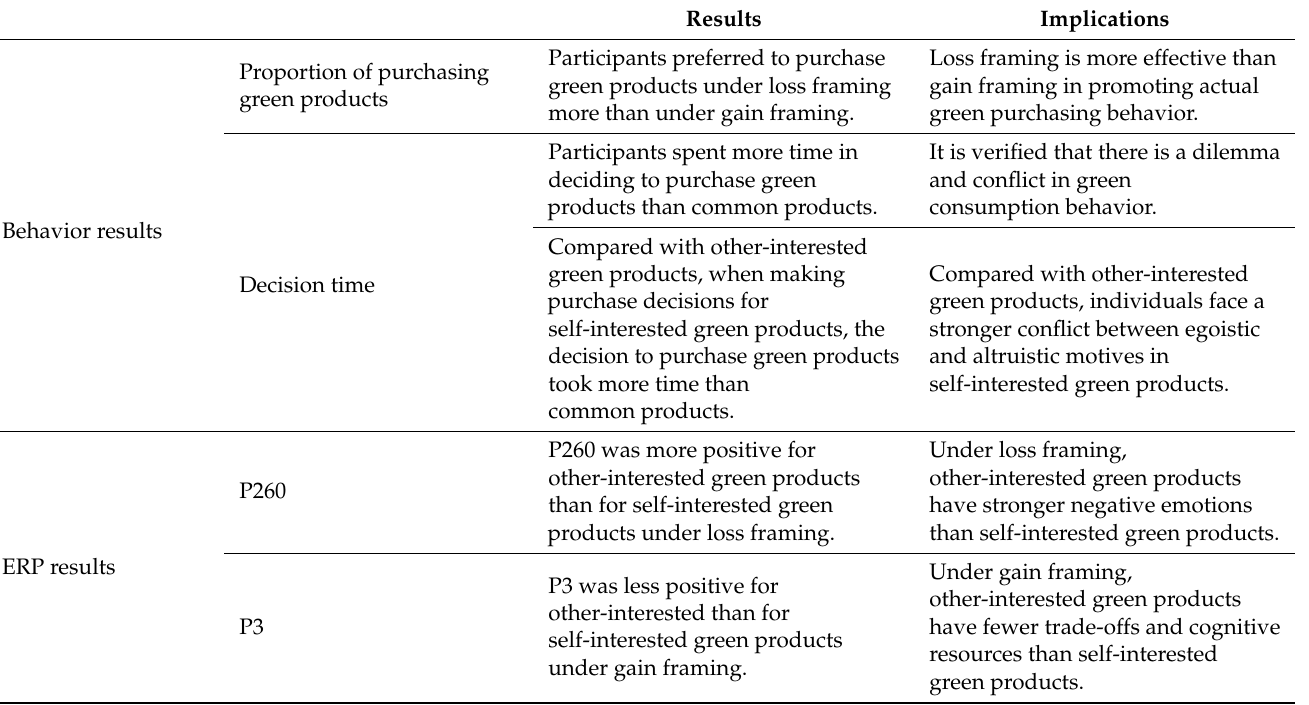
Table 5. A table summarizing the results and